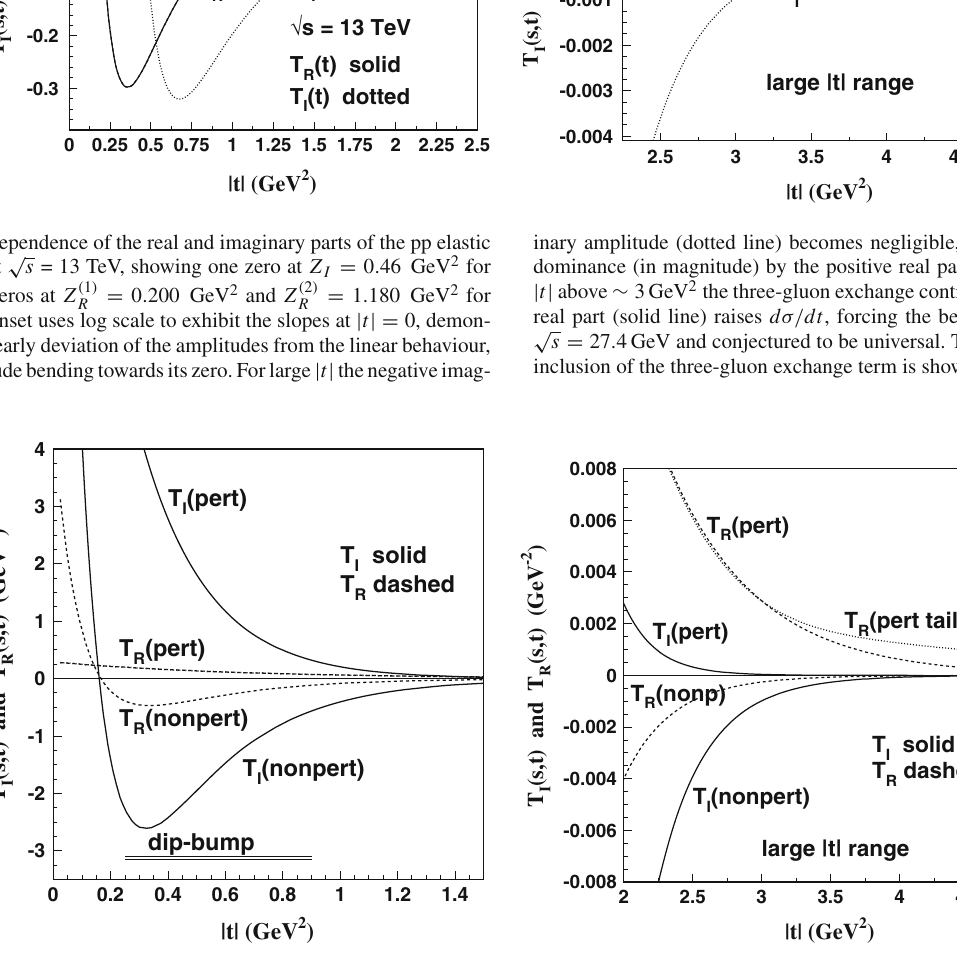
ticularly so in the real amplitude (thus the evaluation of the ρ parameter Fig. 7 Perturbative and non-perturbative contributions in T I ( t ) and T R ( t ) . In the figure we call T K ( pert ) = α K e − β K | t | , T K ( nonpert ) = is mainly a non-perturbative affair). After the bump, T I ( pert ) is negli- λ ψ (γ , t ) ,(with K = I , R ),and T ( perttail ) = T ( pert ) + R ( t ) . gible compared to T I ( nonpert ) , which becomes negligible compared to K K K R R ggg T R ( pert ) for | t | ≥ 3 GeV 2 . For large | t | , only T R ( pert ) (or T R ( perttail It is important to observe that λ I /α I ≈ 25 / 15 and λ R /α R ≈ 15, so that the forward direction is dominated by the non-perturbative term, par-